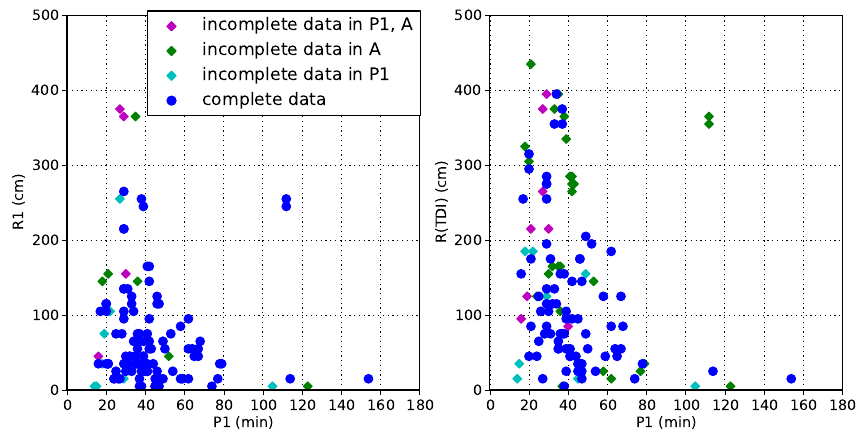
Fig. 5. Plots of the ranges R1 (left) and R(TDI) (right) in function of the period P1. In each graph diamonds are values that are uncertain in one or both of the plotted variables (owing to missing samples or record saturation), while circles are good